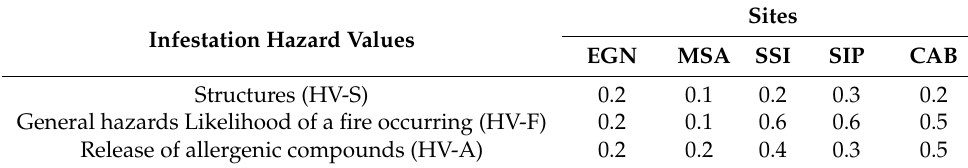
Table 5. Infestation Hazard Values calculated in each site. Infestation Hazard